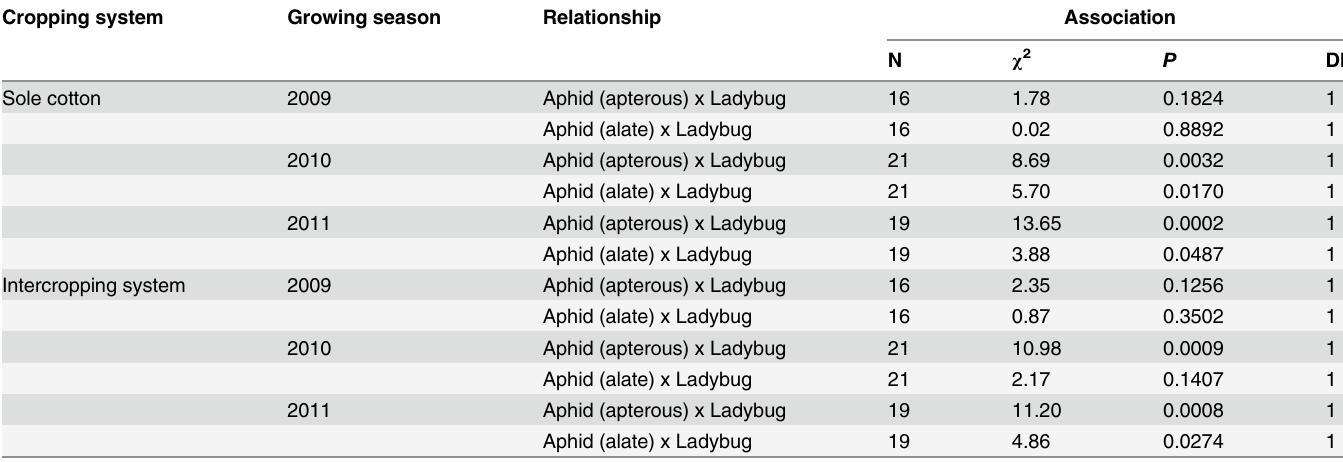
Table 2. Association between C . sanguinea and A . gossypii (apterous and alate) found in sole cotton and coloured cotton-fennel intercropping systems. Cropping system